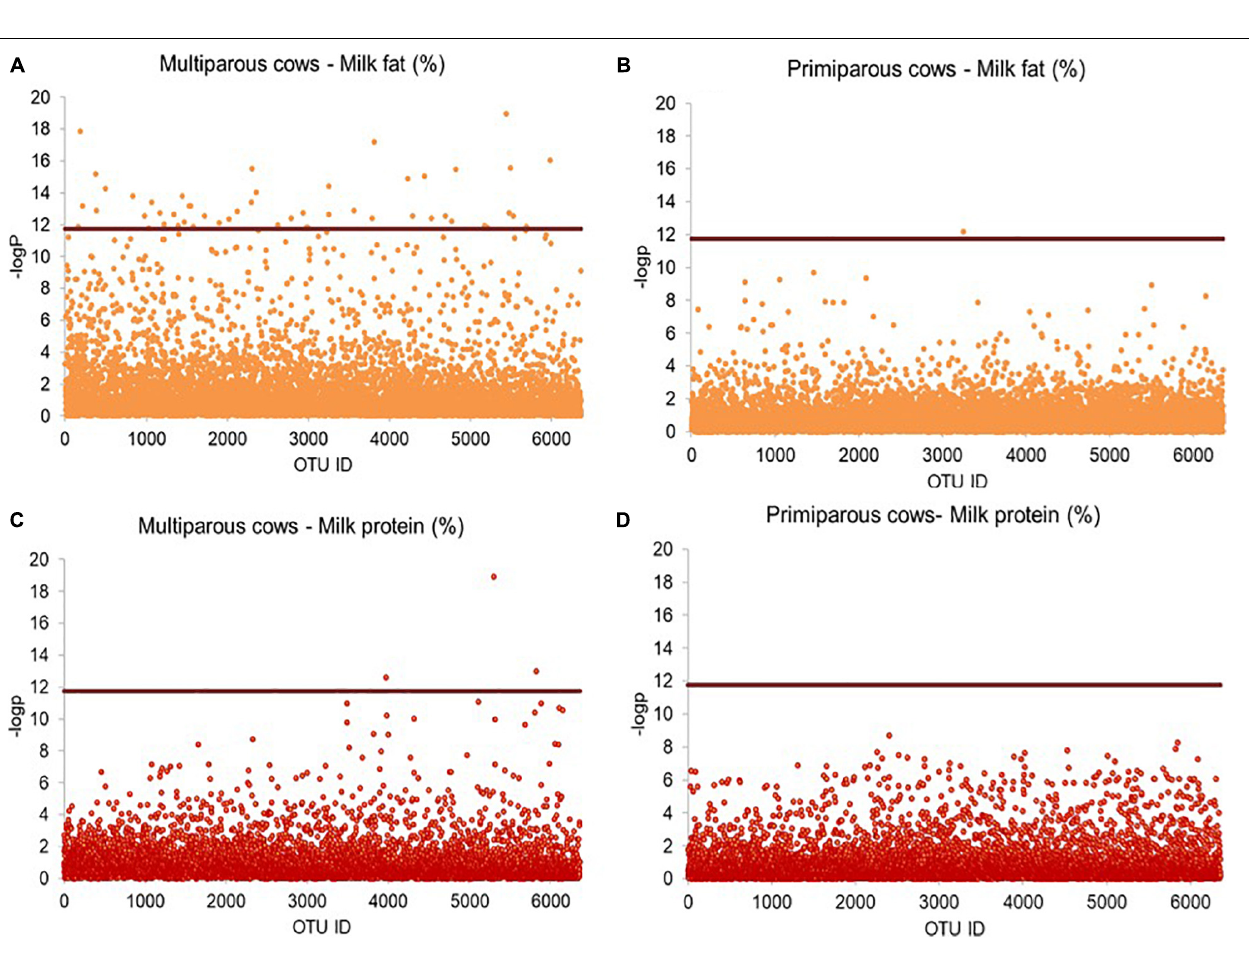
FIGURE 5 | Comparison between multiparous and primiparous cows in OTUs significantly associated with milk traits. Rarified sequence number of individual OTUs was used as input for the linear mixed model-based significance detection. Negative log base 10 transformed P value of individual OTUs ( y -axis) was plotted against their corresponding OTU identities ( x -axis). Bonferroni correlation (0.05/6,363) is used as baseline for significance control as indicated by red line and individual OTUs are represented by open blue circle. The OTUs above the red baseline are considered as OTUs with significant effect on milk traits. Milk fat percentage of (A) multiparous cows and (B) primiparous cows, milk protein percentage of (C) multiparous cows and (D) primiparous cows are shown in scatter plots.